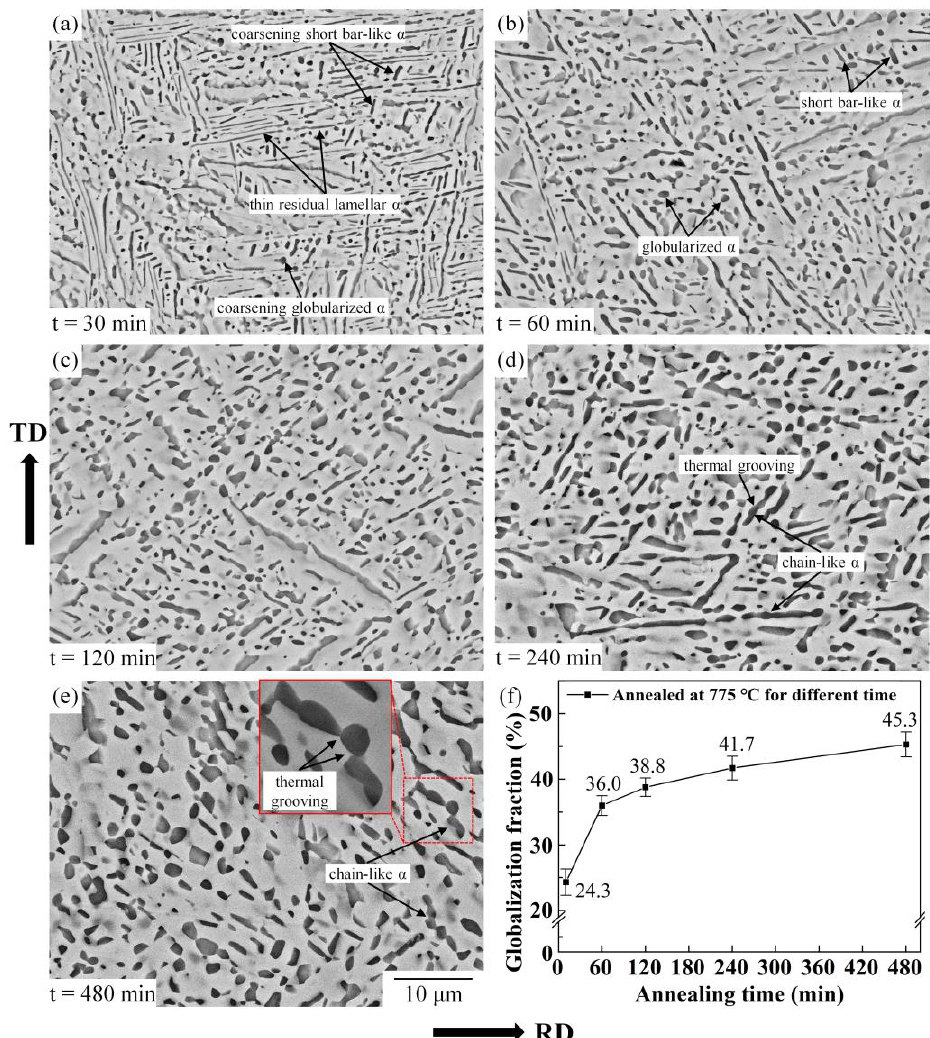
Figure 7. Microstructure of Ti-55511 alloy deformed to a strain of 0.83 and annealed at 775 °C for different times: ( a ) 10 min, ( b ) 60 min, ( c ) 120 min, ( d ) 240 min, ( e ) 480 min; and ( f ) the globularization fraction of α phase .